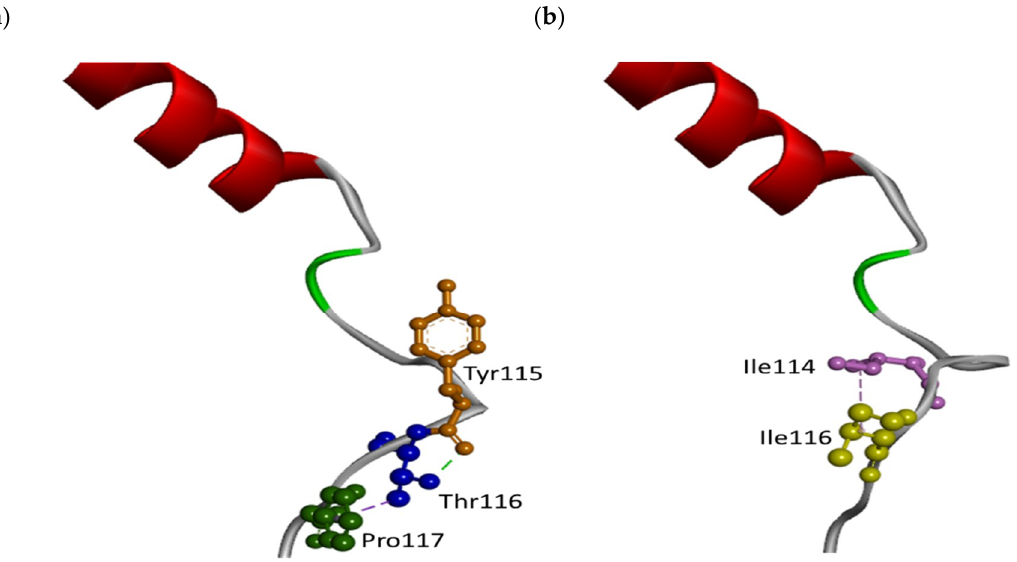
Figure 4. 3D model on PSEN1 Thr116Ile mutation, in terms intramolecular interactions. ( a ) Thr116 (blue) could form hydrogen bond with Tyr115 (orange) and may form hydrophobic interactions with Pro117 (green). ( b ) In the case of Ile116 (yellow), both contacts could be lost, and an additional hydrophobic interaction would be formed with Ile114 (purple).